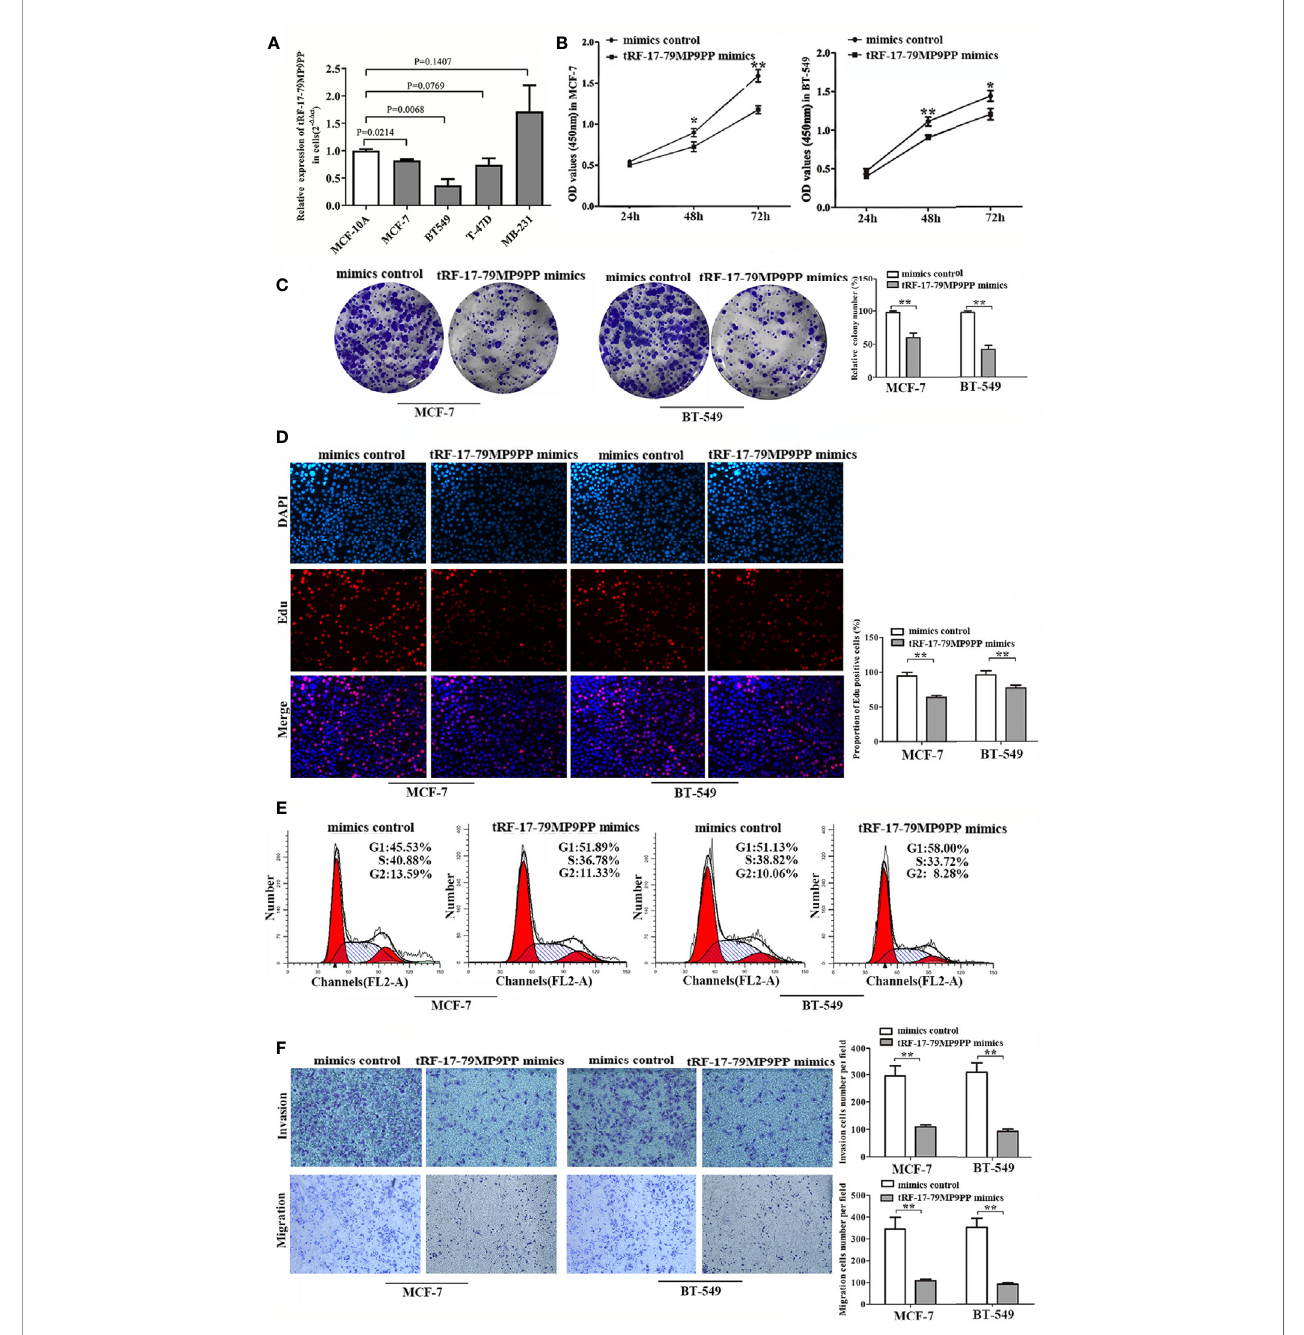
FIGURE 3 | tRF-17-79MP9PP suppresses breast cancer cell malignant activity. (A) The expression of tRF-17-79MP9PP in normal mammary epithelial cell lines MCF-10A and breast cancer cells. (B) Cell viability of breast cancer cell lines after transfection with tRF-17-79MP9PP mimics or mimics control and detection by CCK-8 assay. (C, D) Colony formation assay and Edu assay of treated cells. (E) Cell cycle analysis in treated cells by fl ow cytometry. (F) Representative images and bar graphs were depicted to investigate the migration and invasion ability in treated cells. * p < 0.05; ** p < 0.01, statistically signi fi